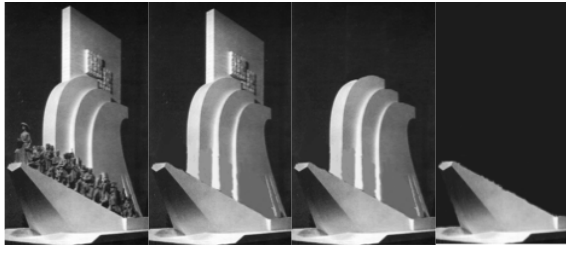
FIGURE 8 | Decomposition of the Monument to the